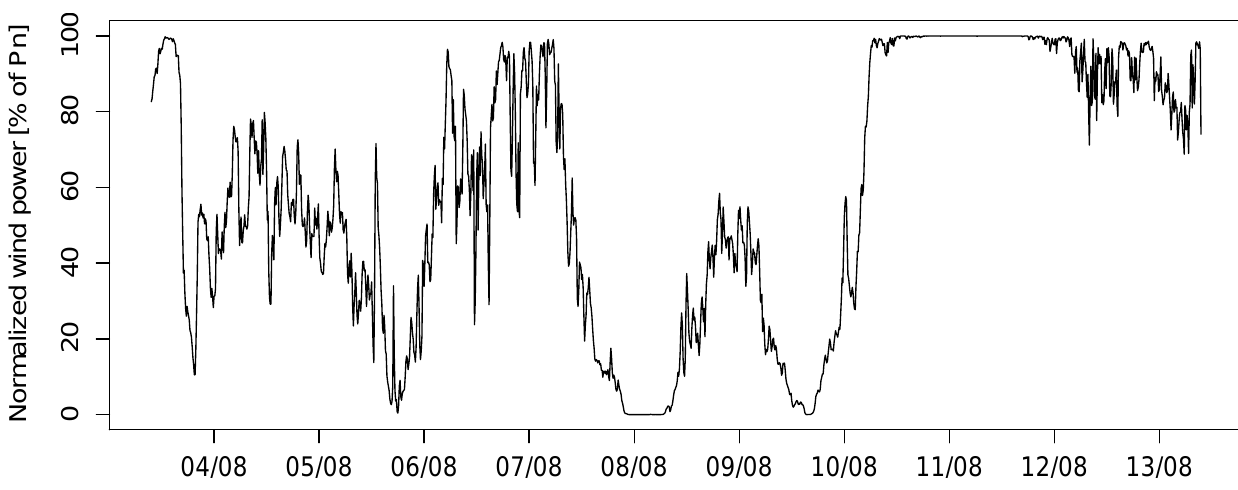
Figure 1. Time series of normalized wind power generation at Horns Rev I over a 10 day episode in August 2005. The time series is sampled with a temporal resolution of 10